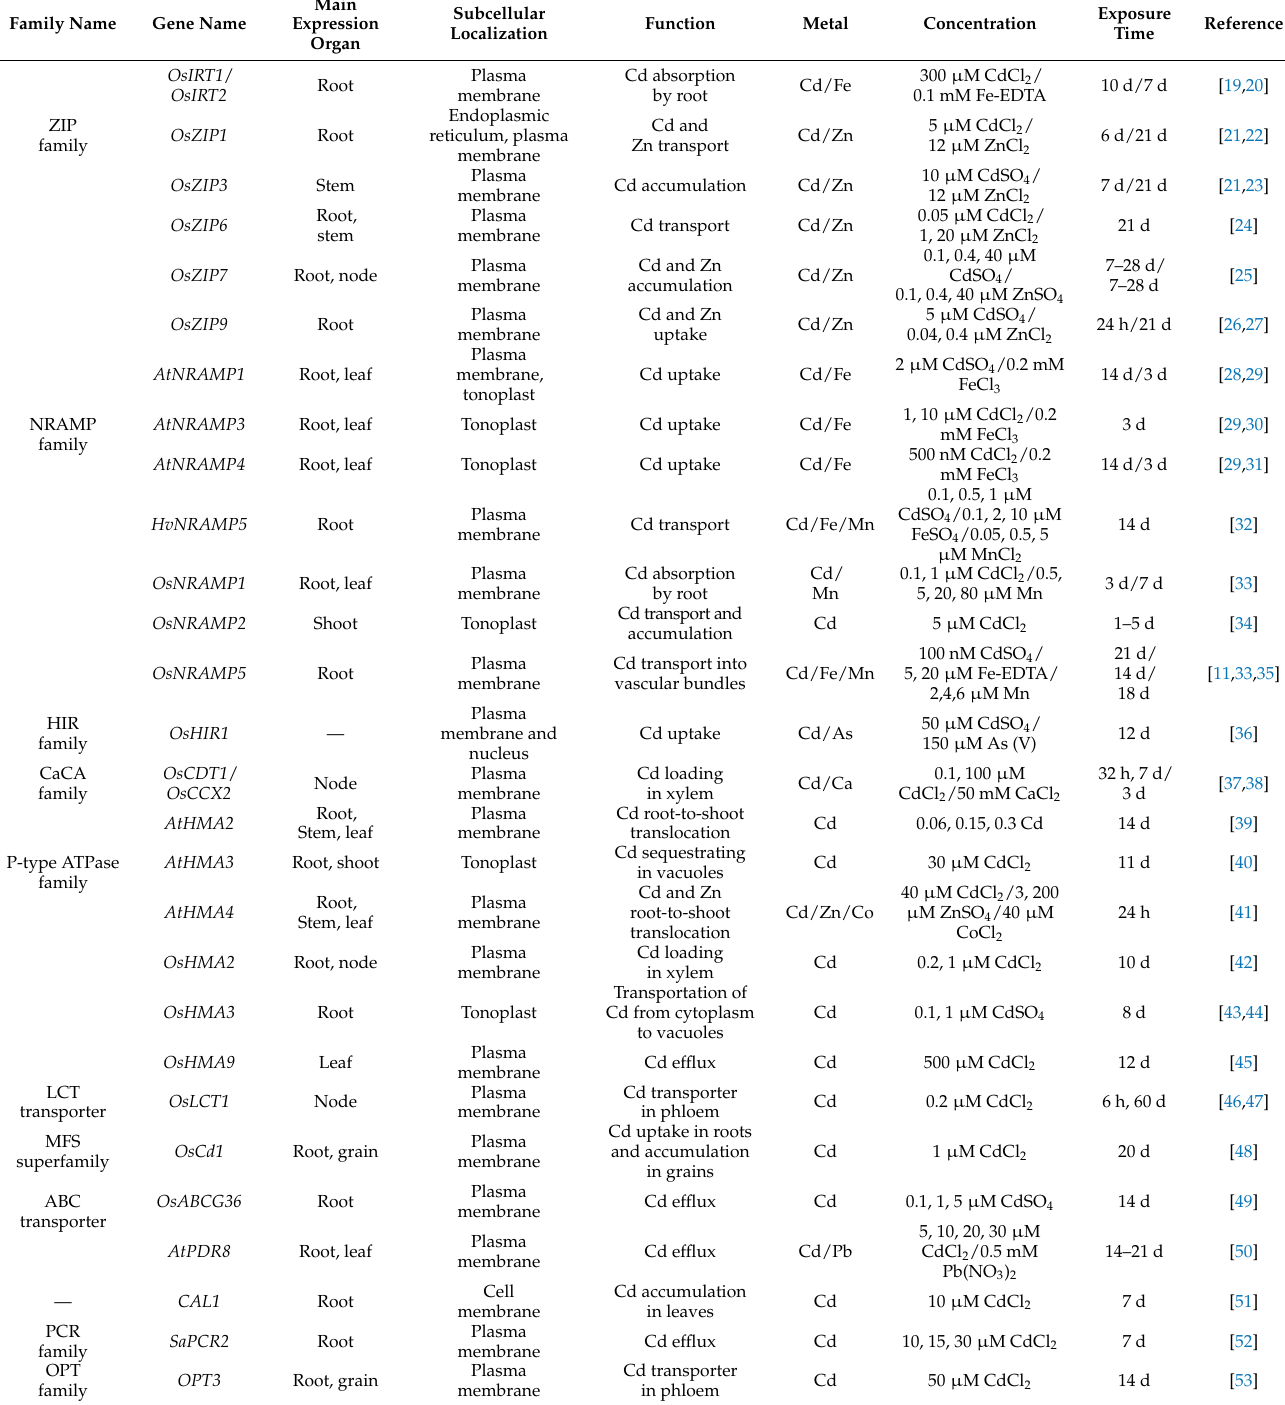
Table 1. Genes involved in Cd uptake, transport, sequestration, and detoxification in